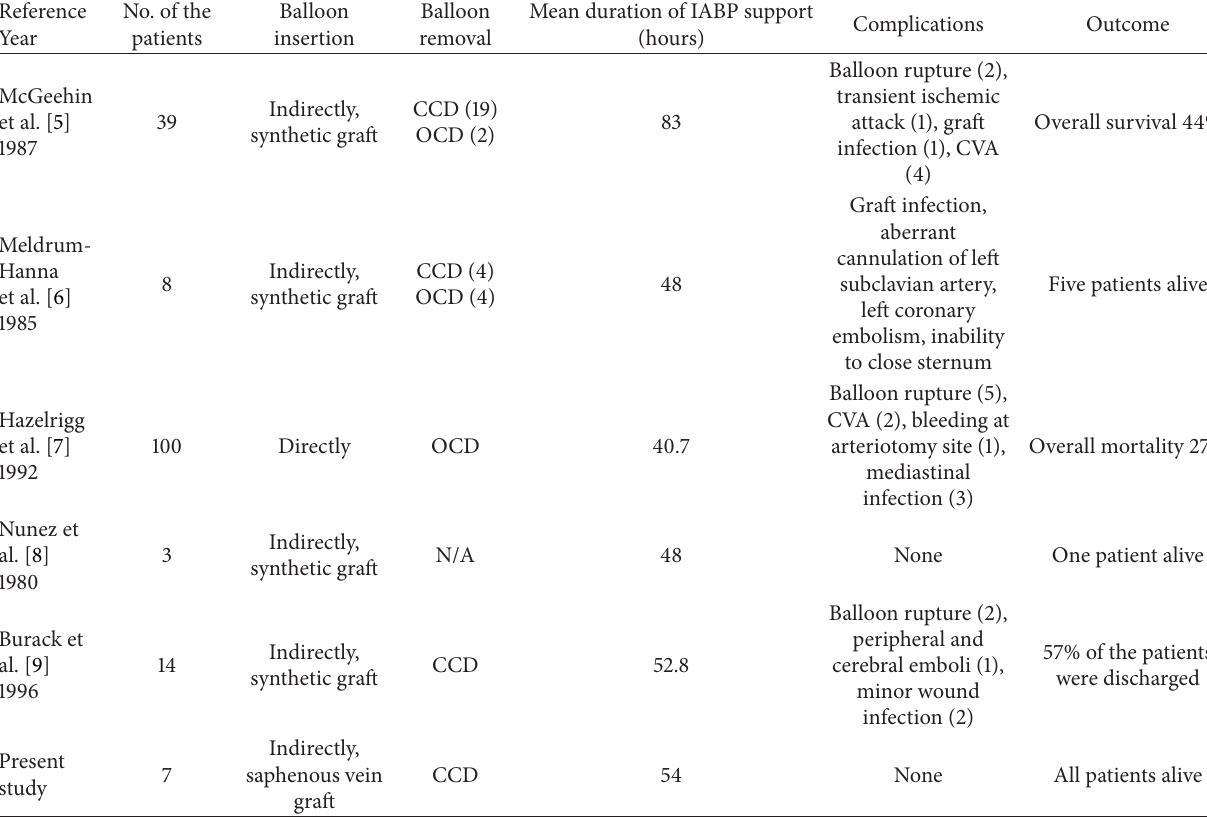
Table 3: A series of transaortic IABP catheter